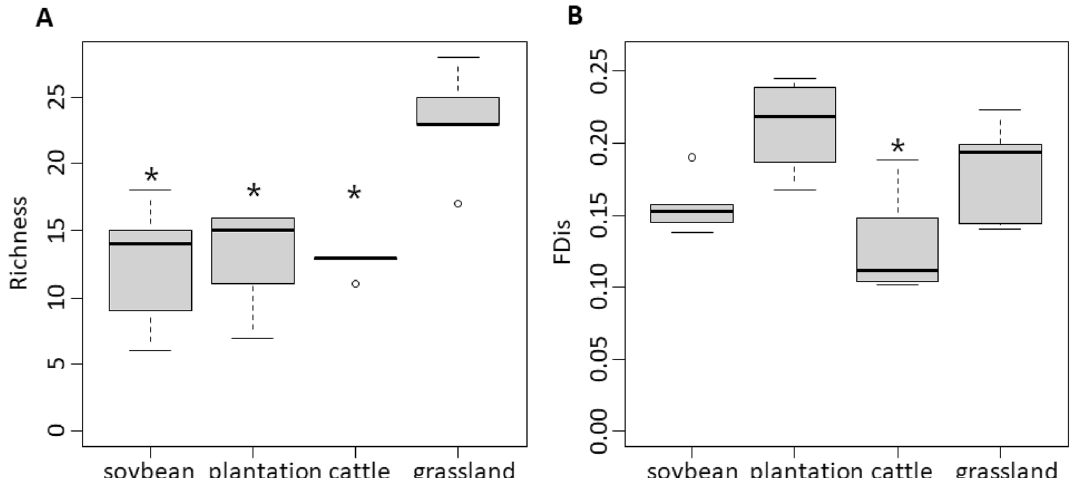
Figure 3. Boxplot of spider richness ( A ) and functional diversity ( B ) in different land-use types and seminatural grasslands. The central line represents the median, boxes include the third and first quartiles, whiskers show maxima and minima, and circles represent suspected outliers. Asterisks represent significant differences between the means of land-use types and seminatural grasslands ( p <